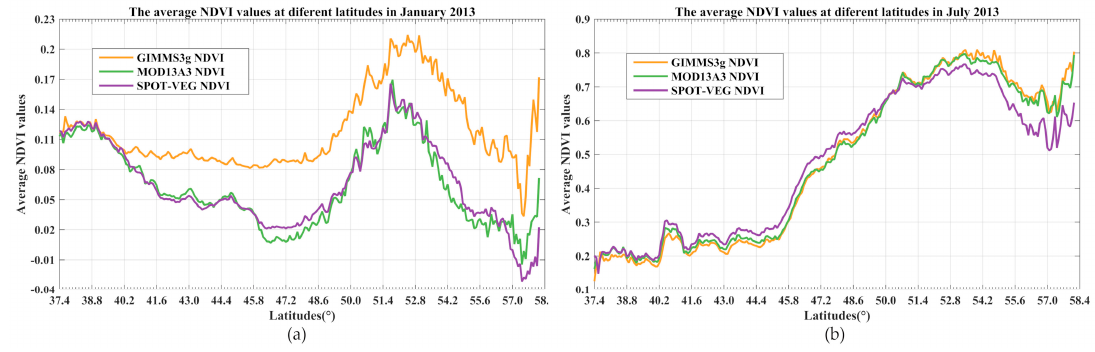
Figure 8. Average NDVI values at different latitudes from 37.4 ° N to 58.4 ° N in ( a ) January 2013 and ( b ) July 2013.